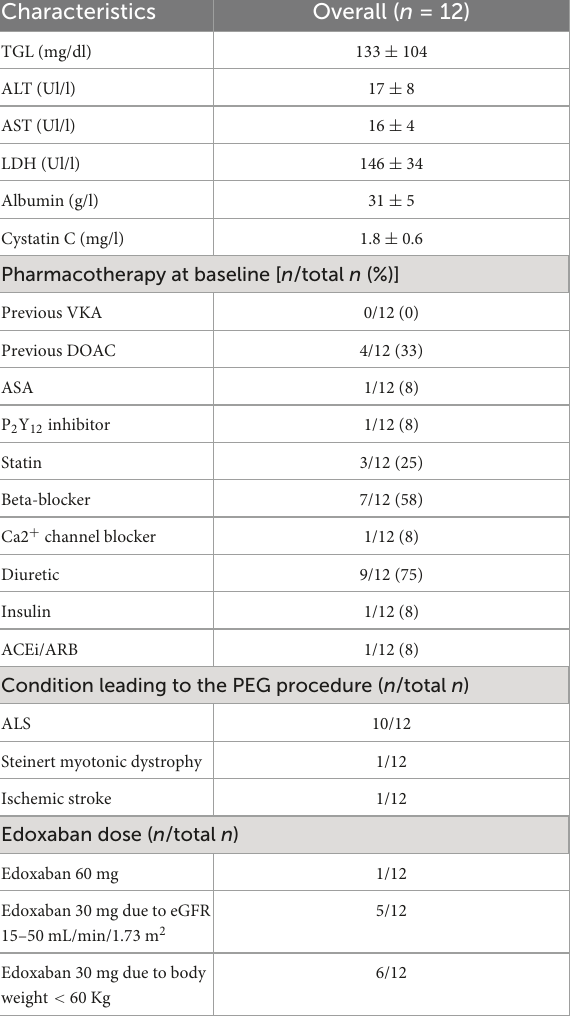
angiotensin-converting-enzymeinhibitors;ARB,angiotensinIIreceptorblockers.